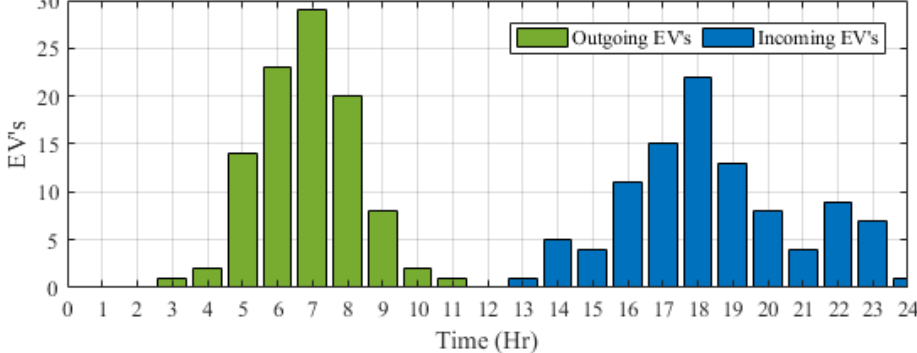
Figure 4. Probability of EVs’ time in and time out.